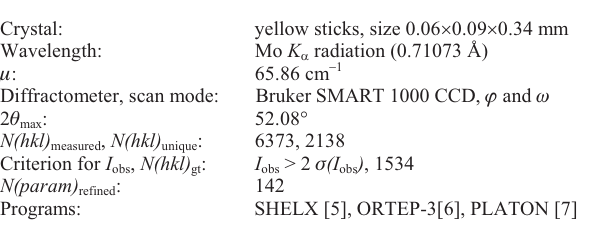
Table 1. Data collection and handling.